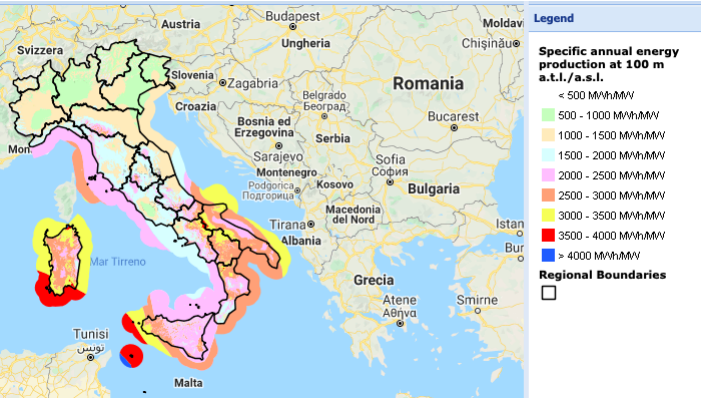
Figure 11. Specific producibility of onshore wind at 100 m (above ground level) and offshore wind at 100 m (above sea level)